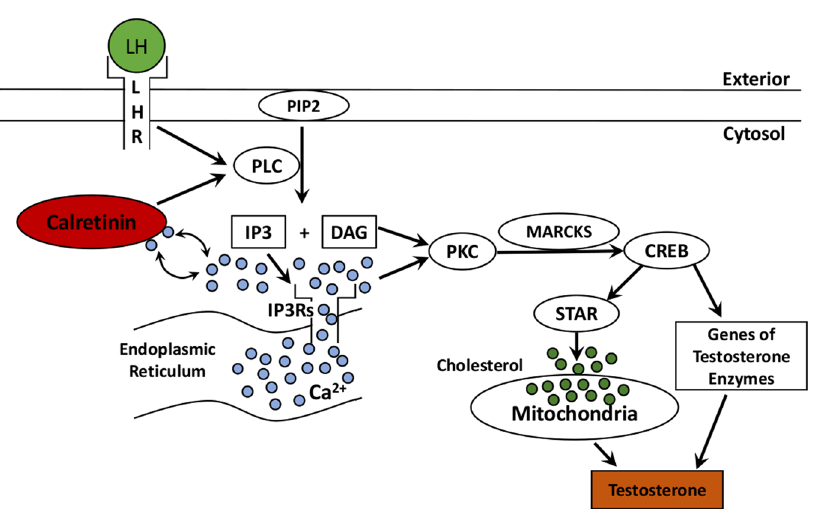
Figure 7. Calretinin participates in the regulation of steroidogenesis by PLC-Ca 2 + -PKC pathway in Leydig cells. LH/LHR activates PLC, and PLC then divides PIP2 into γ DAG and IP3. IP3 can activate Ca 2 + channels in endoplasmic reticulum. Ca 2 + together with DAG activates PKC, which phosphorylates MARCKS to promote the expressions of steroidogenetic enzymes, including StAR. Calretinin can buffer free Ca 2 + and regulate the level of intracellular Ca 2 + through the PLC-Ca 2 + -PKC pathway. Ca 2 + , as a second messenger, activates PKC, followed by the phosphorylation of